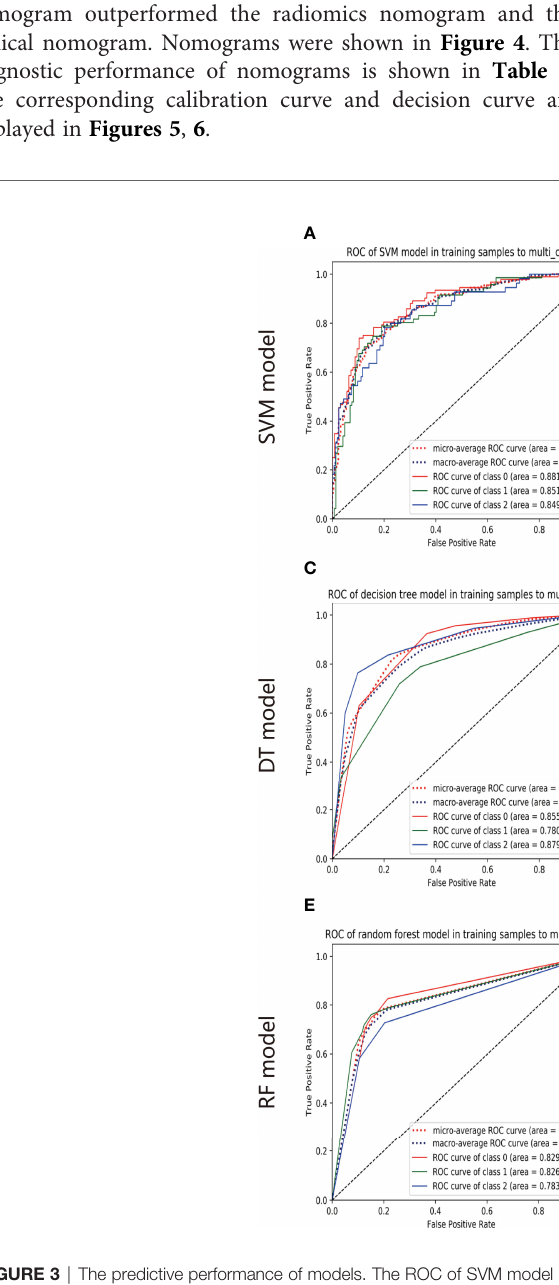
FIGURE 3 | The predictive performance of models. The ROC of SVM model in training set (A) and validation set (B) . The ROC of DT model in training set (C) and validation set (D) . The ROC of RF model in training set (E) and validation set (F)